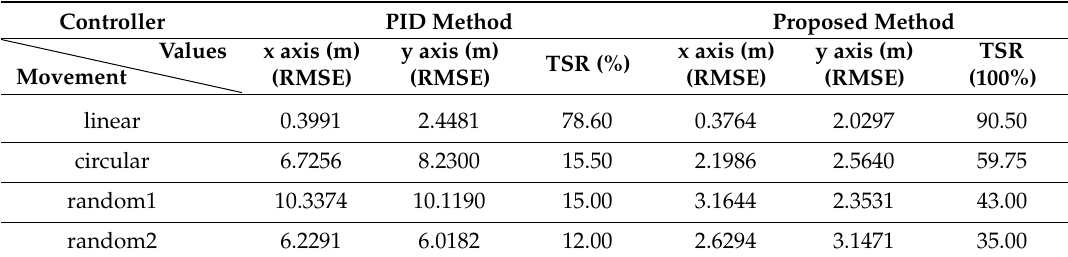
Table 4. Tracking results in an intermittent measurement environment. Root-mean-square error and percentage of steps of the moving platform in the field of view of the UAV are shown in this table.